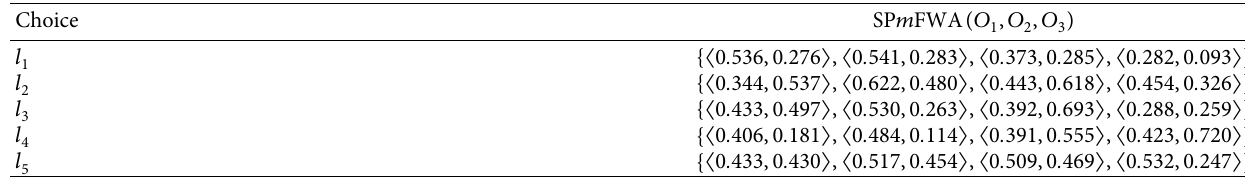
, O , O ) for each 1 2 3